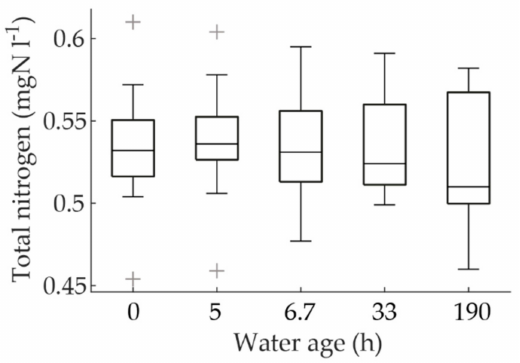
Figure 8. The variation of the total nitrogen concentrations by water